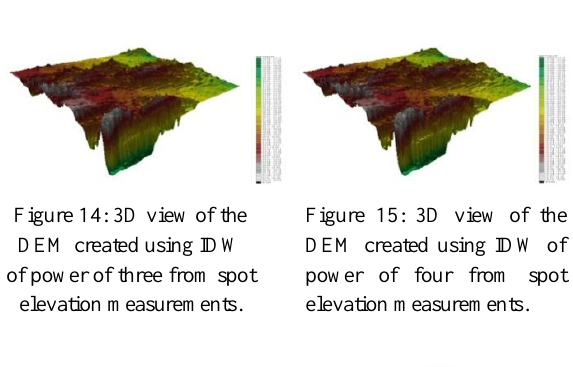
Figure 12: 3D view of the DEM created using IDW of power of one from spot elevation measurements.